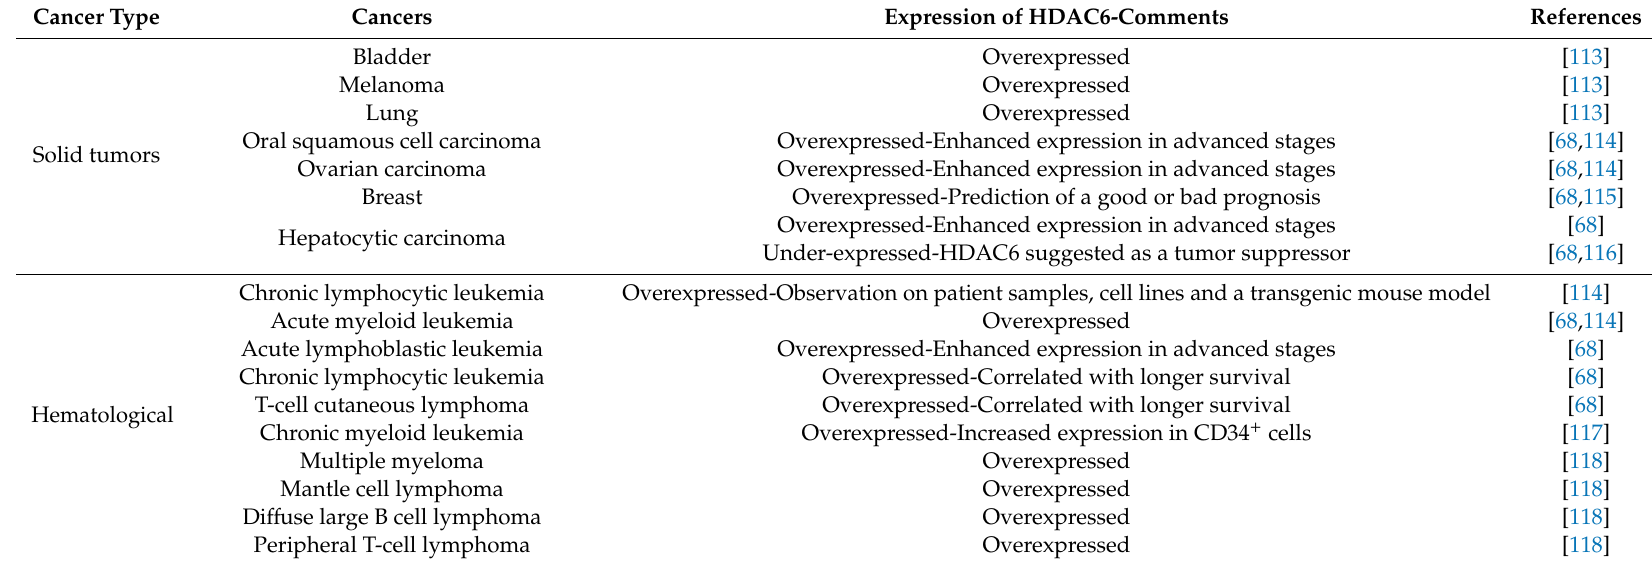
Table 7. Deregulation of HDAC6 expression in di ff erent types of